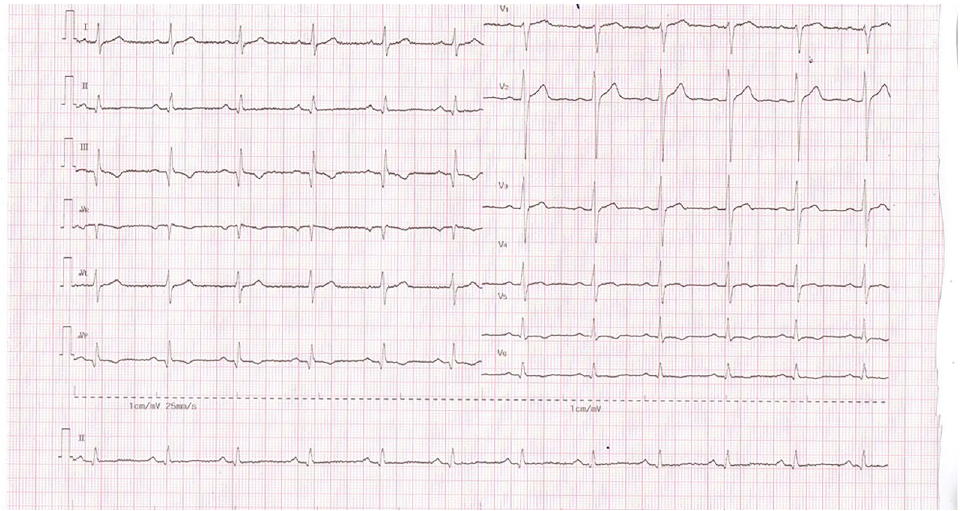
Figure 1. ECG SafOne 12-lead ECG recording.